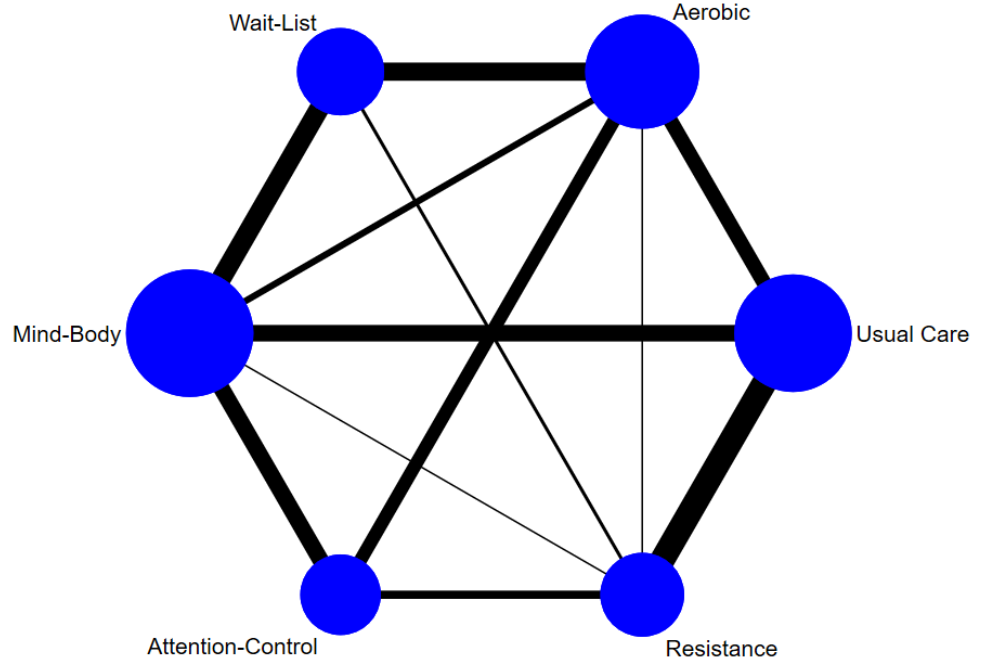
Figure 2. Network plot of comparisons for all studies included in the network meta-analysis. Line width is proportional to the number of pairwise effect size estimates and node size is proportional to the number of participants.